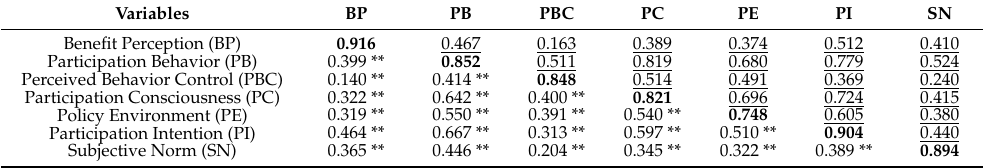
Table 4. Discriminant validity—Fornell-Larcker Criterion and Heterotrait-Monotrait